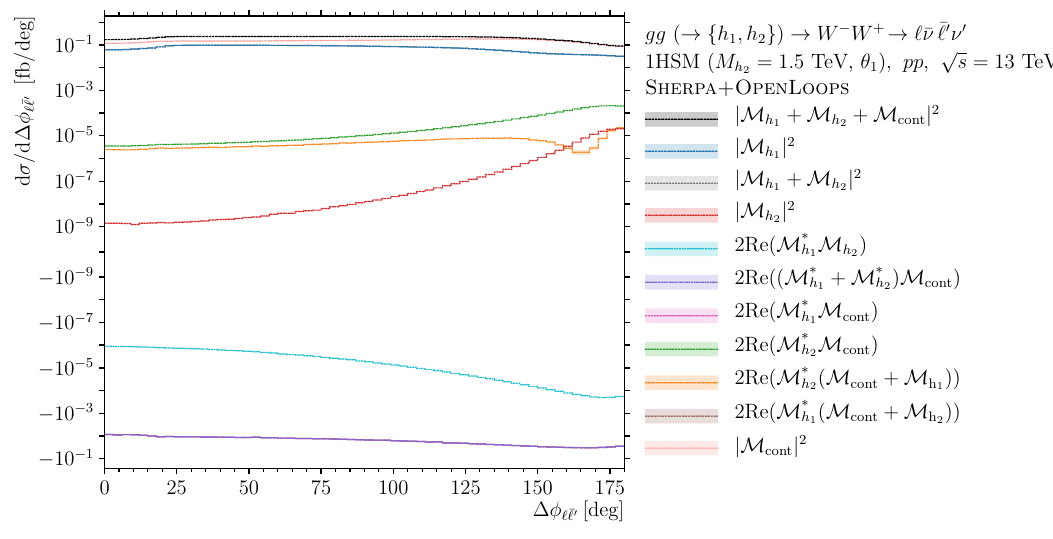
h 1 , h 2 ) W − W + (cid:26) ¯ ν ¯ (cid:26) (cid:30) ν (cid:30) in → { } → →